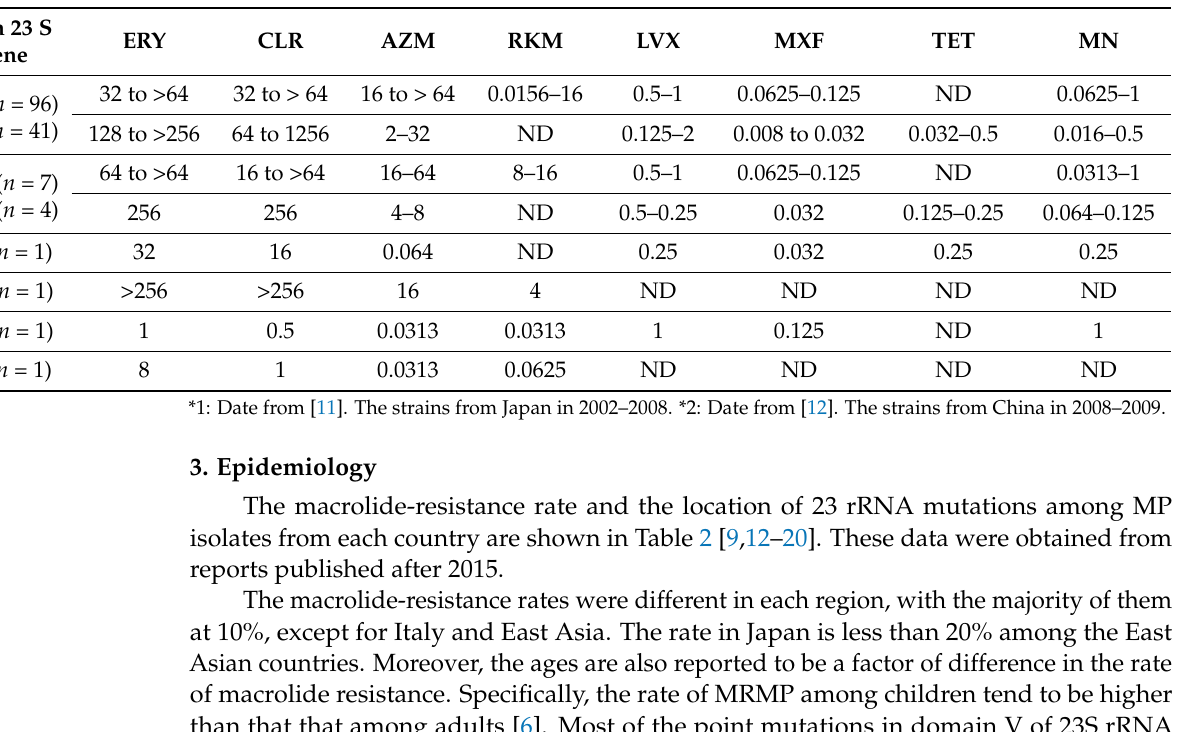
Table 1. MICs of macrolide and other antibiotics for M. pneumoniae isolated from patients and refer- ence strains; ( µ g/mL) erythromycin (ERY), clarithromycin (CLR), azithromycin (AZM),